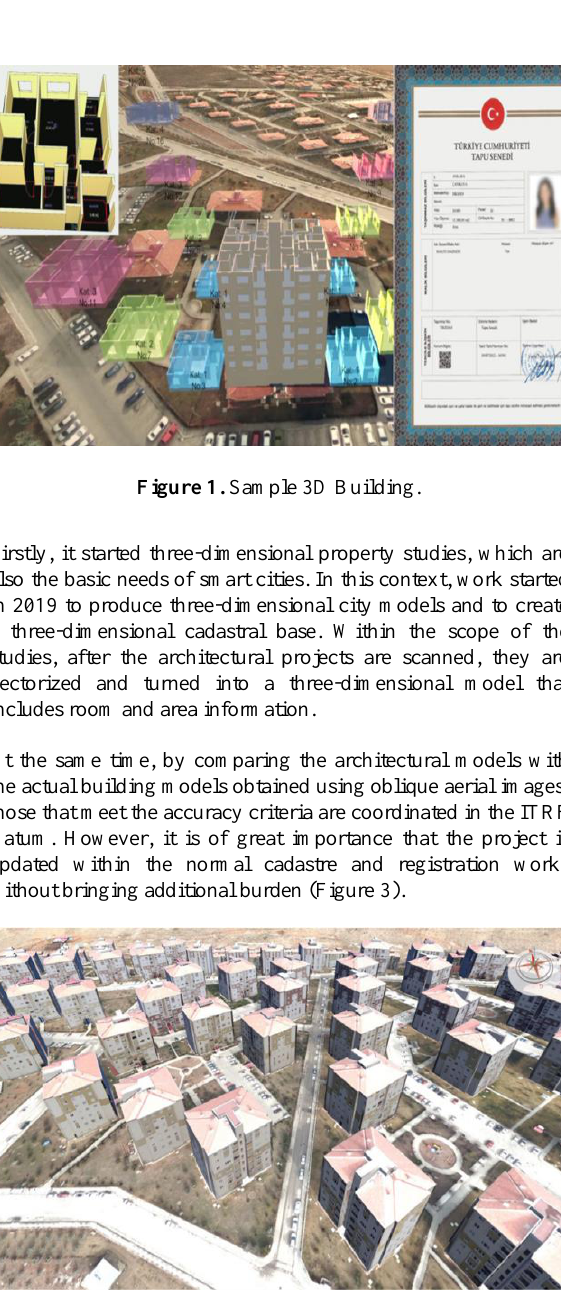
Figure 3. 3D Photogrammetric